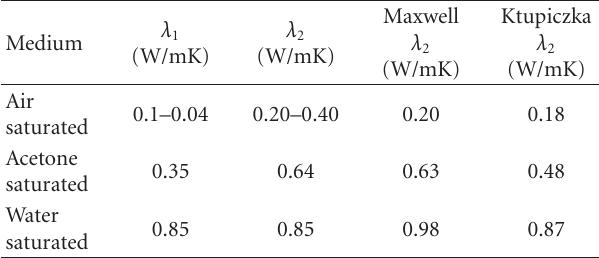
Table 3: Evolution of the λ 1 and λ 2 for the di ff erent dried and saturated states of the glass bead assemblages. Air saturated for 0.45 to 3.0 mean diameters, acetone, and water saturated for 3.0 mm mean diameter, Maxwell, and Ktupiczka calculations